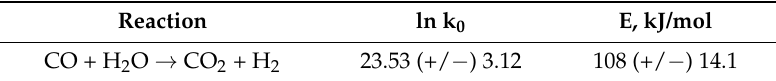
Table 3. Kinetic parameters for the case of the fixed-bed reactor.